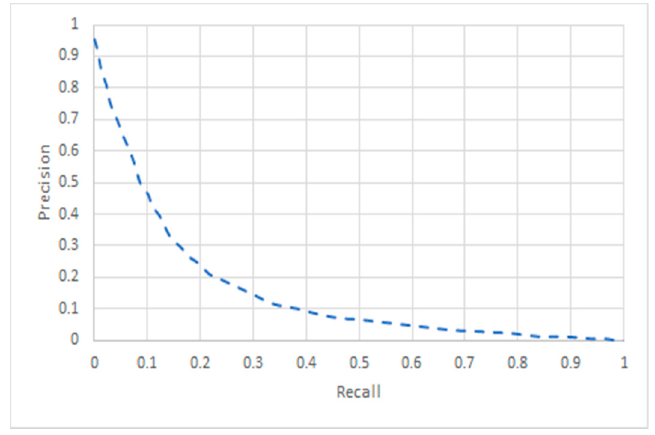
Figure 2. Precision–recall curve.